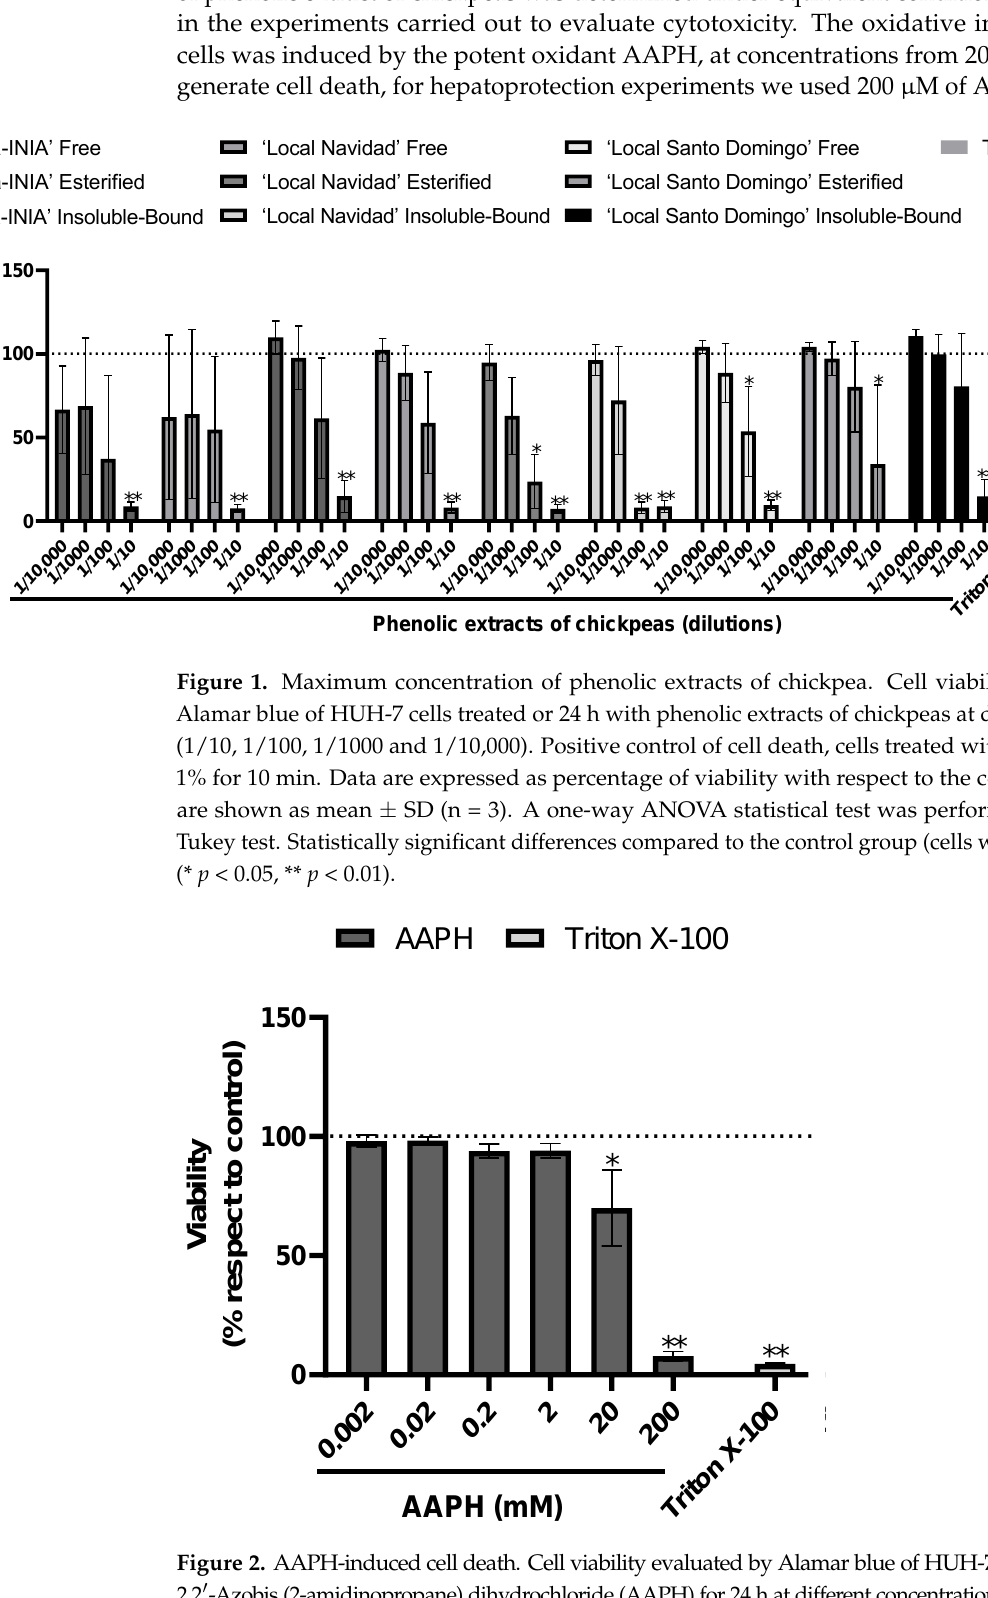
Figure 2. AAPH-induced cell death. Cell viability evaluated by Alamar blue of HUH-7 cells treated with 2,2 ′ -Azobis (2-amidinopropane) dihydrochloride (AAPH) for 24 h at different concentrations (0.002 – 200 mM). Positive control of cell death, cells treated with Triton X-100 at 1% for 10 min. Data are expressed as percentage of viability with respect to the control cells only with vehicle. Data are shown as mean ± SD (n = 3). A one-way ANOVA statistical test was performed followed by Tukey test. Statistically significant differences compared to the control group (cells without treatment) (* p < 0.05, ** p < 0.01).